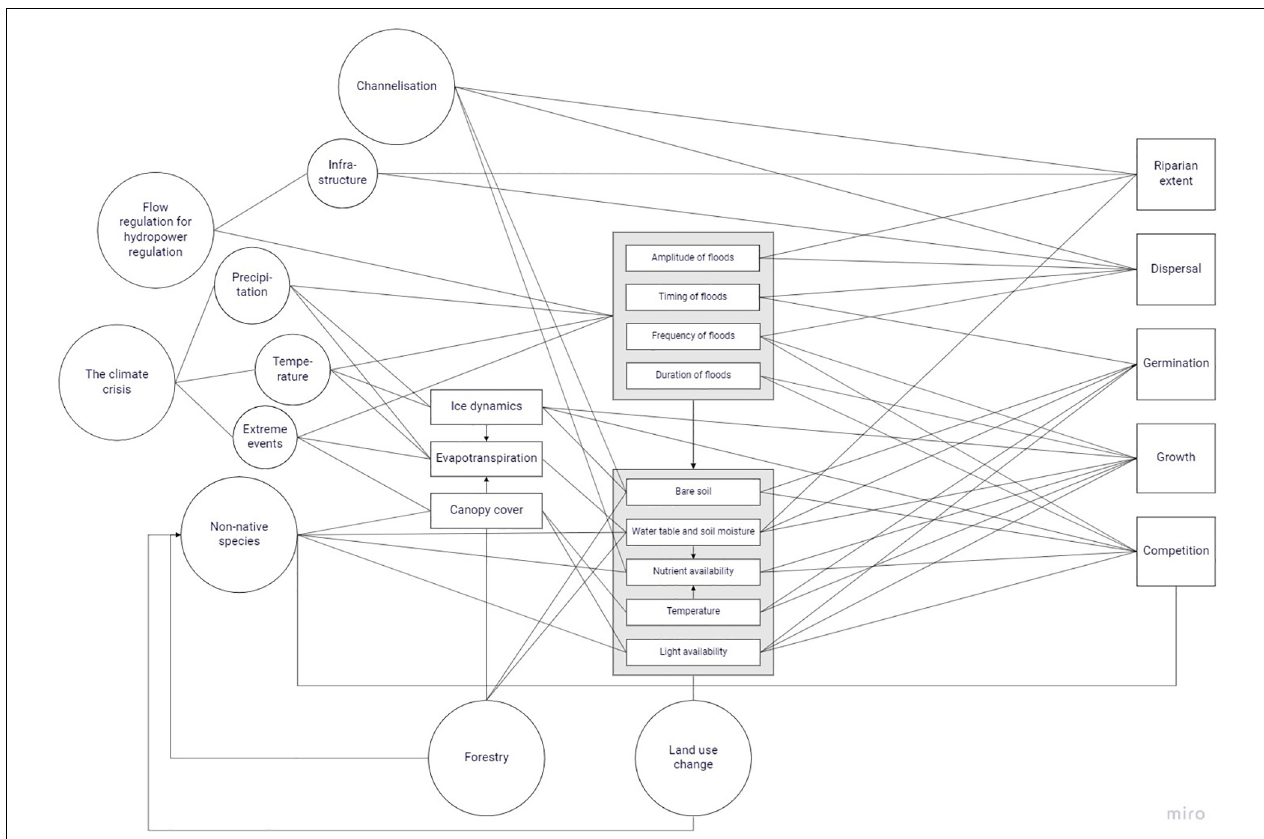
FIGURE 3 | Conceptual model of the main potential effects of anthropogenic pressures on processes and habitats in the boreal riparian zone. Circles are pressures and pressure components, rectangles are intermediates, partially grouped as belonging to the flow regime (upper shaded rectangle) or the microhabitat (lower shaded rectangle), and squares are characteristics of and processes in the riparian zone. Lines and arrows represent effects and can be positive or negative. The effects of “Ice dynamics” change over time with initial intensification of the dynamics and eventual decrease with increasing climatic